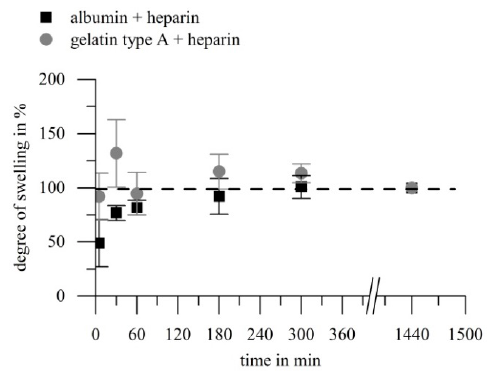
Figure 3. Swelling kinetics of gelatin (10 wt %) or albumin (10 wt %) hydrogels with heparin (1 wt %) crosslinked via EDC (0.125 M). The degree of swelling was determined at different time points and is denoted in % of the degree of swelling of the respective gels after 24 h. Both hydrogel types showed a fast water uptake. Gelatin-based gels passed through a hyper-swollen state after approximately 30 min, while albumin-based gels swelled continuously. Evaluation of the absolute numbers for the degrees of swelling for each gel revealed that after 60 min, no significant variation of degree of swelling (DS) was noticed. ( p > 0.05, n = 4).